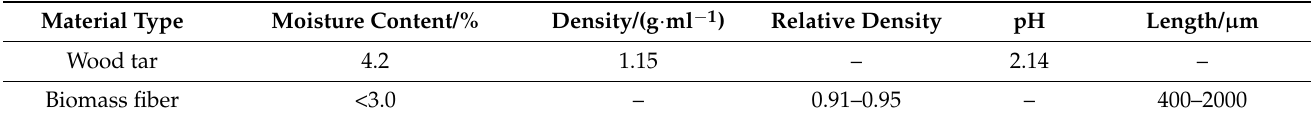
Table 2. Basic properties of wood tar and biomass